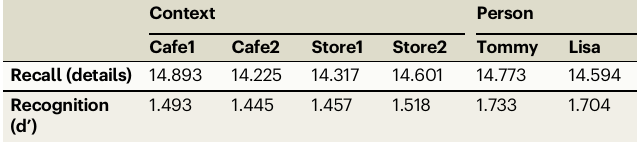
Table 1 | Recall and recognition memory